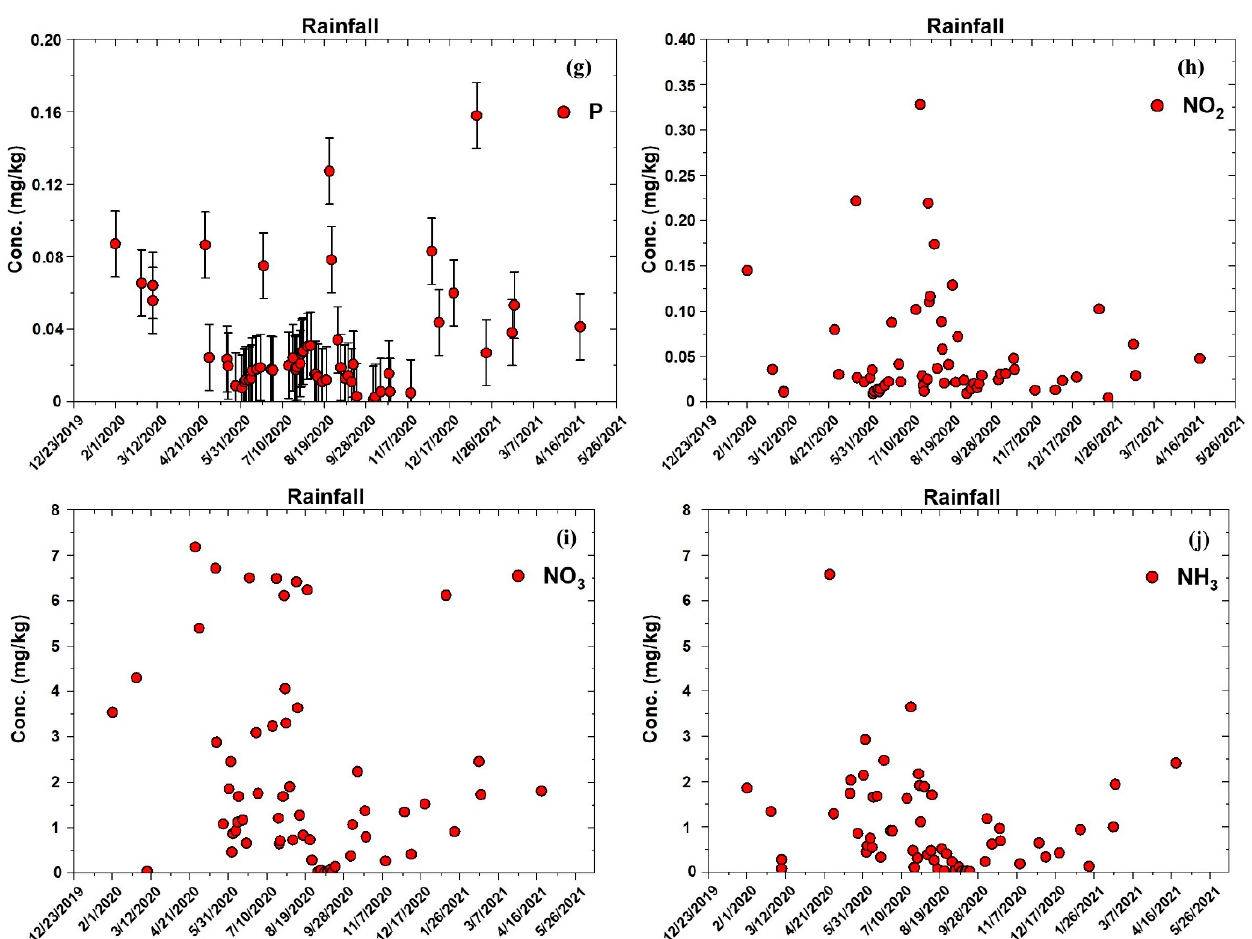
Figure 6. Concentrations of selected metals (Al, Si, Fe, K, Ca, Mg) and nutrients (P, NO 2 , NO 3 , NH 3 ) in rainfall water that were digested using acid. Note that where the error bars are difficult to see, they are small compared to the concentration.